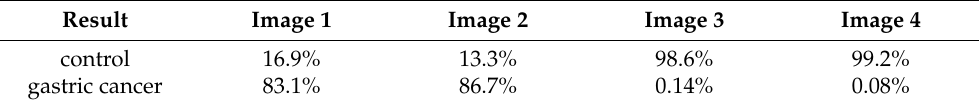
Table 3. The final results of the classification.